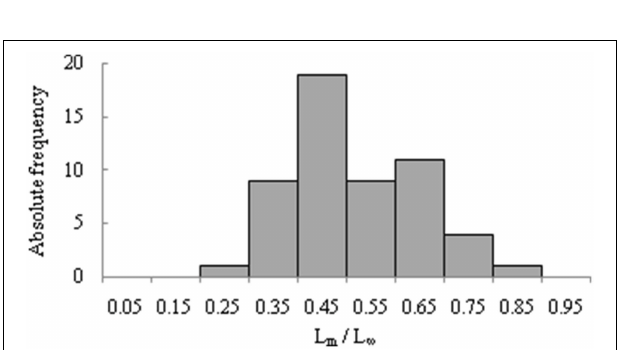
FIGURE 3 | Frequency distribution of reproductive load (L m /L ∞ ) for Brazilian marine fishes.